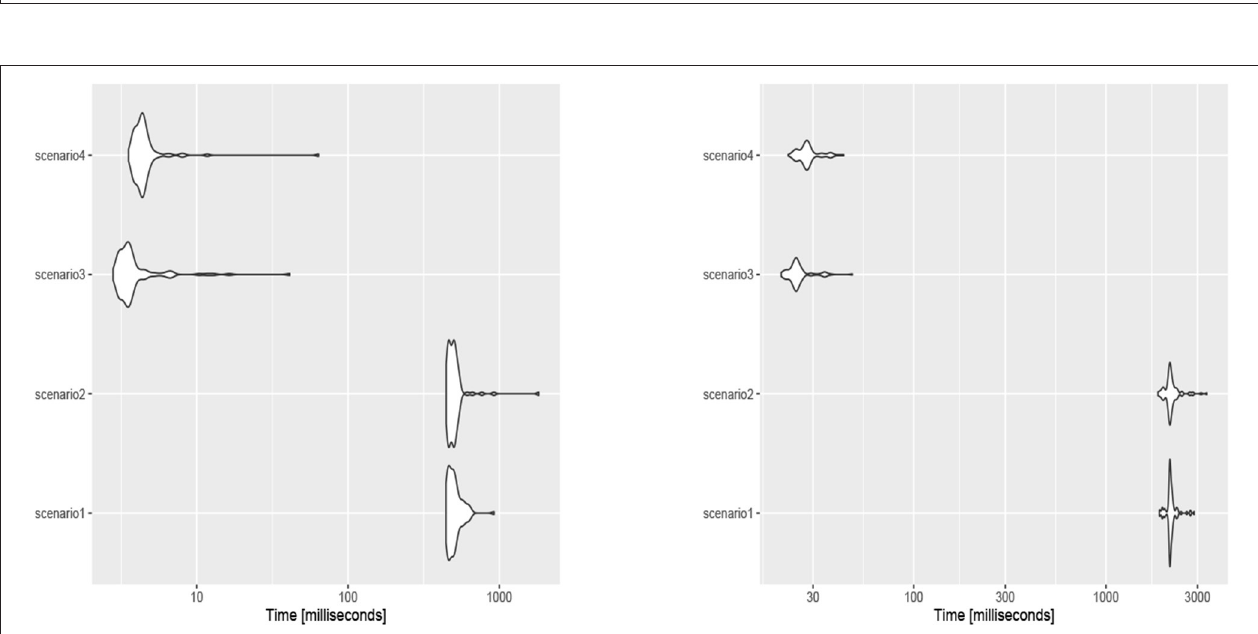
FIGURE 7 | The execution time (in miliseconds) for generating samples of size n